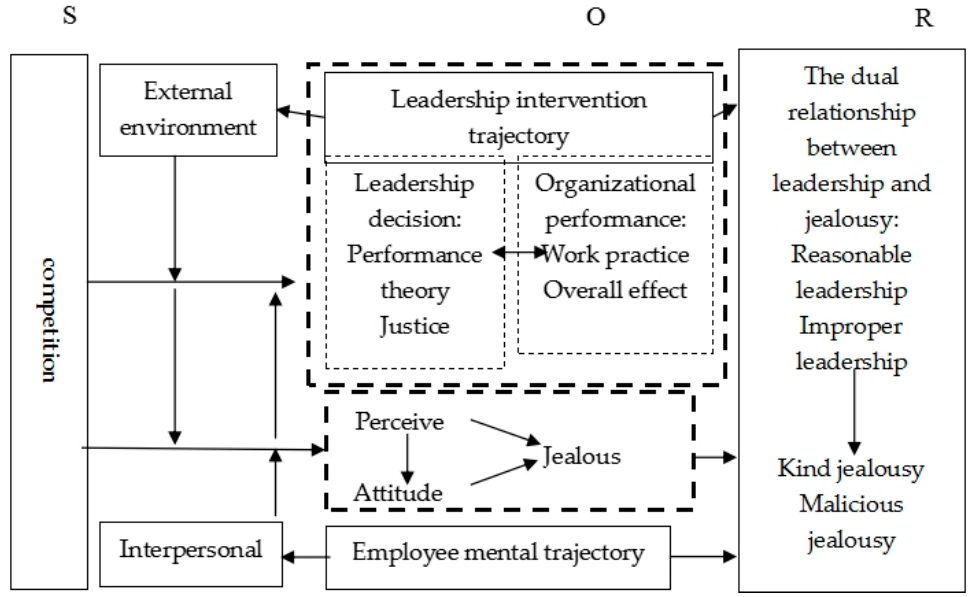
Figure 4. The dual-track relationship model of leadership and envy.